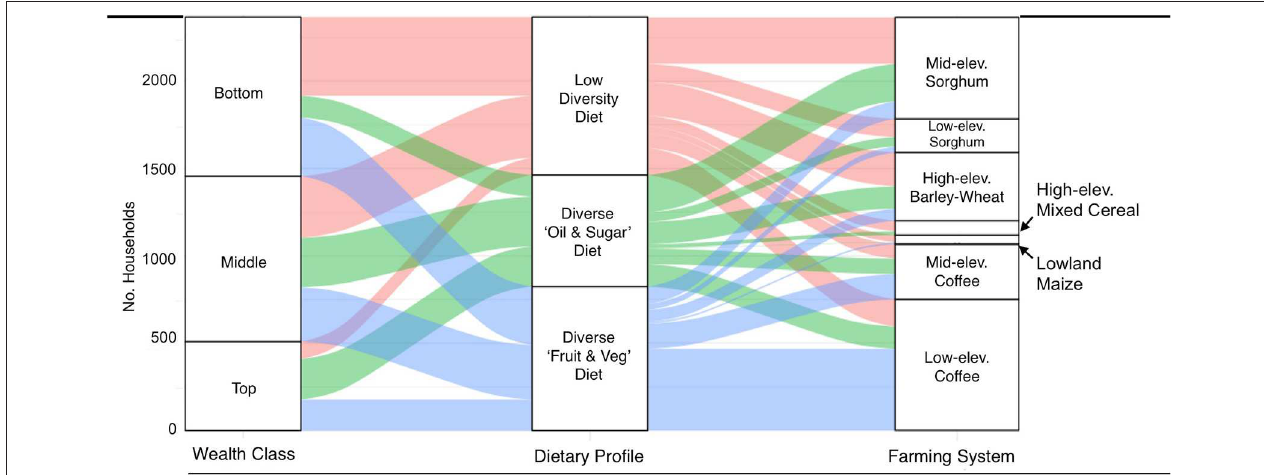
FIGURE 4 | Alluvial flow diagram showing the (left-hand side) breakdown in the numbers of households from the bottom, middle, and top wealth classes with a Low Diversity (pink), Diverse OS (green) and Diverse FV (blue) diet profile, and (right-hand side) the breakdown in the number of households from different farming systems in each diet